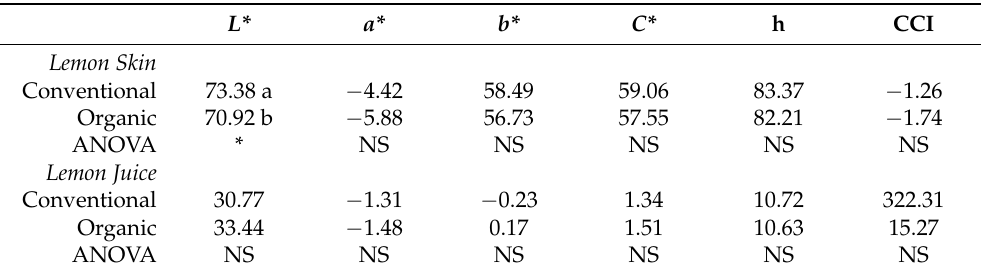
Table 3. Color analysis of lemon skin and lemon juice under organic and conventional farming. L* a* b* C* h CCI Lemon